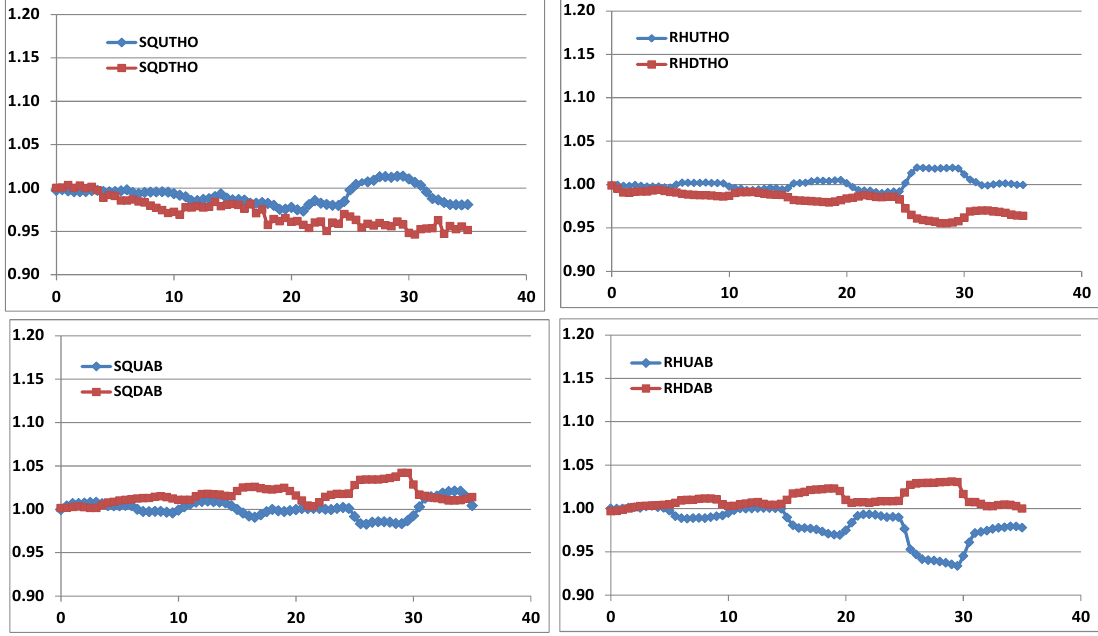
Figure 1: Squirrel (SQ) and Rhesus (RH) monkey thoracic (THO) and abdominal (AB) upper body volume changes during short-term head up (U) and head down (D) tilt. See text for explanation.